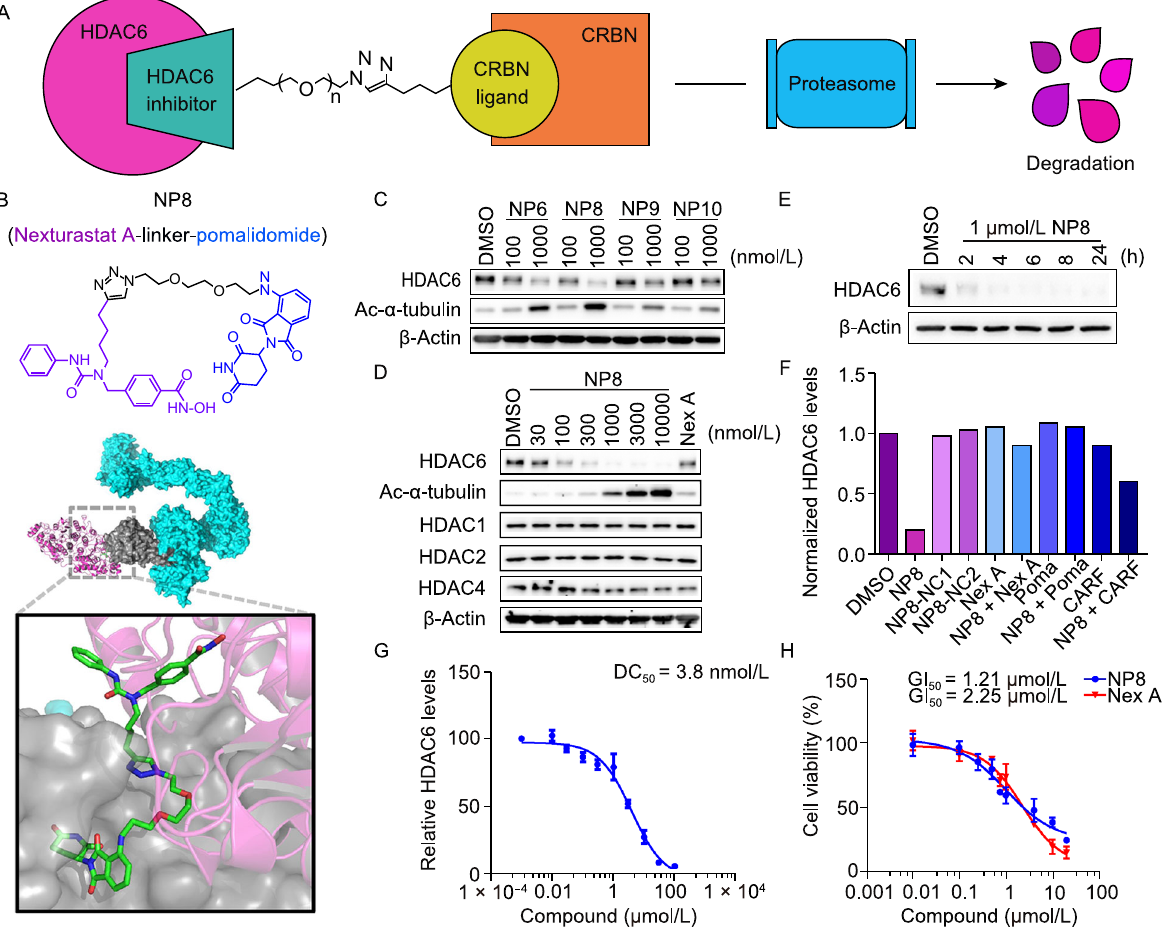
Figure 1. Development of selective HDAC6-degrading PROTACs . (A) The principle of PROTAC. (B) The structure of PROTAC, as shown in the upper portion. A binding mode of PROTAC (ball stick), HDAC6 (PDB 5G0J, purple) and CRL4-CRBN (PDB 2HYE and 4CI3, colored cyan and gray) was simulated by Pymol. (C) Screen for a potent HDAC6 degrader. HeLa cells were treated as indicated for 24 h. (D) Characterization of NP8-induced degradation in HeLa cells. The degradation of HDAC6 was in a dose-dependent manner. The HDAC1, HDAC2 and HDAC4 levels were not affected within 24 h. (E) NP8 caused fast degradation of HDAC6 within 2 h in HeLa cells. (F) NP8-NC1 and NP8-NC2 failed to degrade HDAC6. NP8 induced degradation was rescued by single introduction of Nexturastat A (Nex A, 300 nmol/L), Pomalidomide (Poma, 10 µmol/L) or Car fi lzomib (CARF, 1 µmol/L). The concentration of NP8- NC1, NP8-NC2 and NP8 were 300 nmol/L. HeLa cells were treated with Car fi lzomib for 6 h and 24 h for the rest. (G) The degradation of HDAC6 by titration of NP8 for 24 h in MM.1S cells. (H) MM.1S cells were treated with NP8 or Nexturastat A (Nex A) for 72 h. Cell viability was determined by CCK-8 assay ( n =